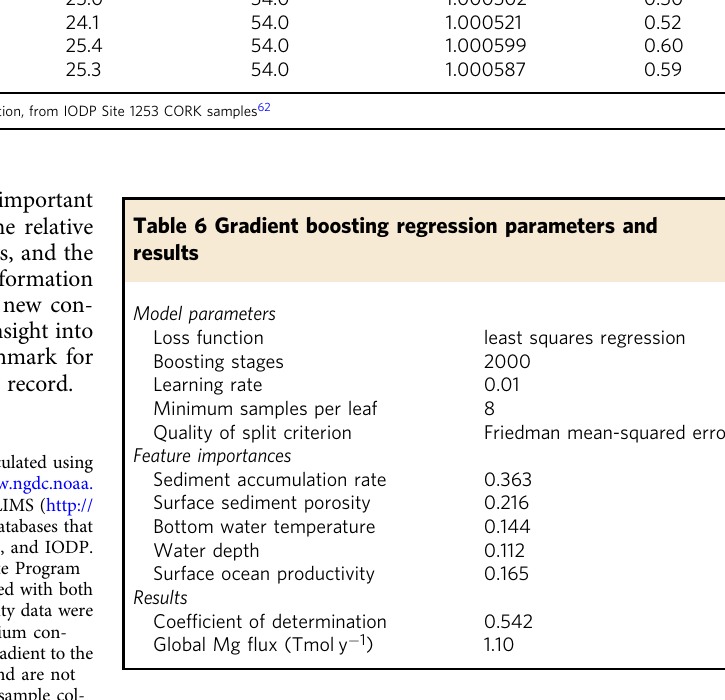
Table 1. The data are all resampled to 5-min grid-registered grids using the Rasterio Python package. For sediment accumulation rate, long-term average sediment accumulation rate is calculated, as in Burwitcz et al., (2011) 53 , where sediment thickness in each grid cell is divided by the underlying crustal age. For sediment thicknesses, the Whittaker (2013) 54 dataset is used where available, with the Laske and Masters 55 – 57 dataset being used where needed. Regression model parameters and cross-validation . Cross-validation is used to evaluate the accuracy of the regression, and to compare it to other potential methods. See Table 6 and Supplementary Tables 2 and 3 for the model parameters and Fig. 3 and Supplementary Figs. 1 and 2 for the cross-validation analyses. Three regression methods were compared using Leave-One-Out cross-validation to determine which method was best suited to the ocean drilling dataset. While the gradient-boosting regressor and random forest techniques provide similar pre- dictive power, the gradient-boosting regression technique provides both the best predictive power, and is the most robust option to avoid over- fi tting the model to training data, as indicated by the greater number of samples per leaf. The best- fi t parameters for each method are listed in Table 6 and Supplementary Tables 2 and 3, along with the results of the cross-validation analysis. For gradient-boosting regression and random forest, the feature importances are listed, which are a measure of how much each feature reduces the variance of the model fi t. For the multiple linear regression technique, the linear coef fi cients are listed.